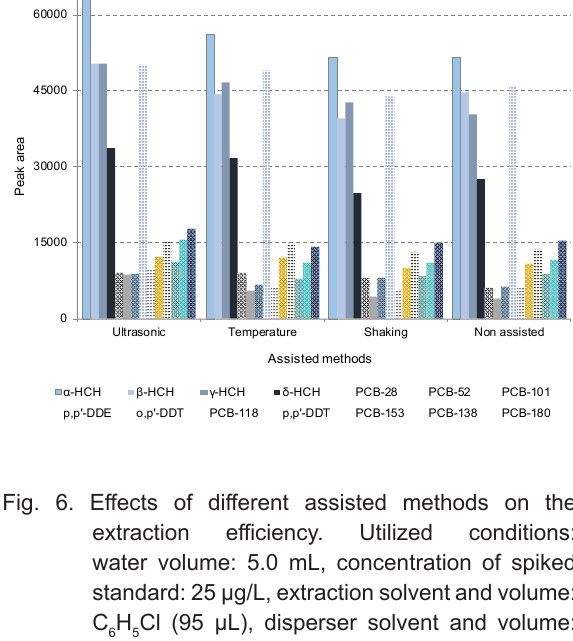
Fig. 6. Effects of different assisted methods on the extraction efficiency.